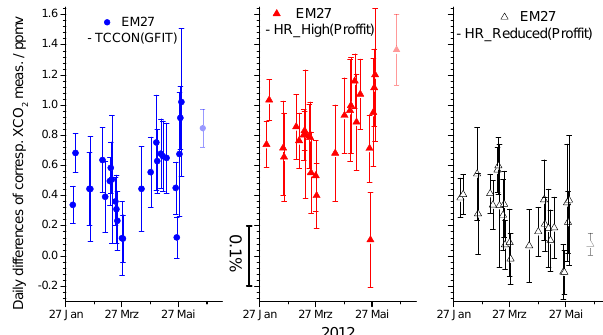
Fig. 11. XCO 2 values with the same data processing as for the O 2 columns in Fig. 10 for the 26 measurement days.